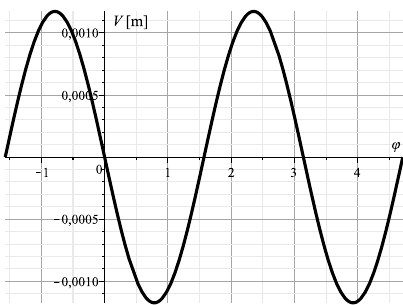
Figure 24: Plot of V ( φ ) (Example 5.3).